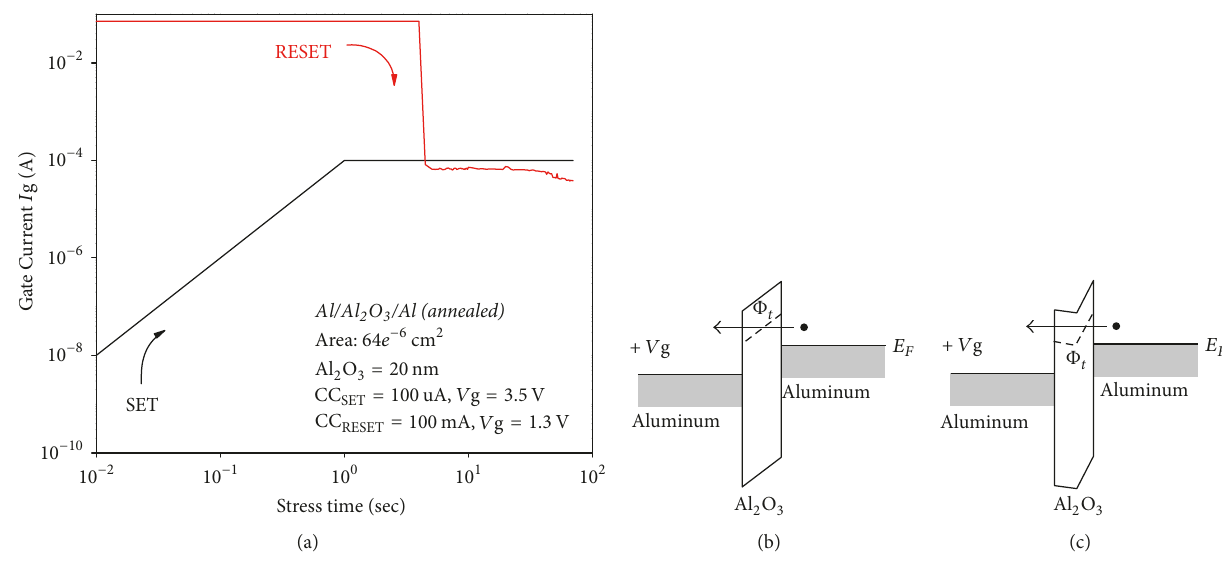
Figure 5: (a) Gate current versus stress time for Al/Al 2 O 3 /Al structure during the SET and RESET conditions. A gradual increase in 𝐼 g during the SET condition is evidence of positive charge trapping in the MIM device. Ideal energy band diagrams for the MIM structure under positive bias and where (b) PF tunneling conduction through Φ 𝑡 is initiated; (c) a large density of trapped positive charge modifies the energy gap of Al 2 O 3